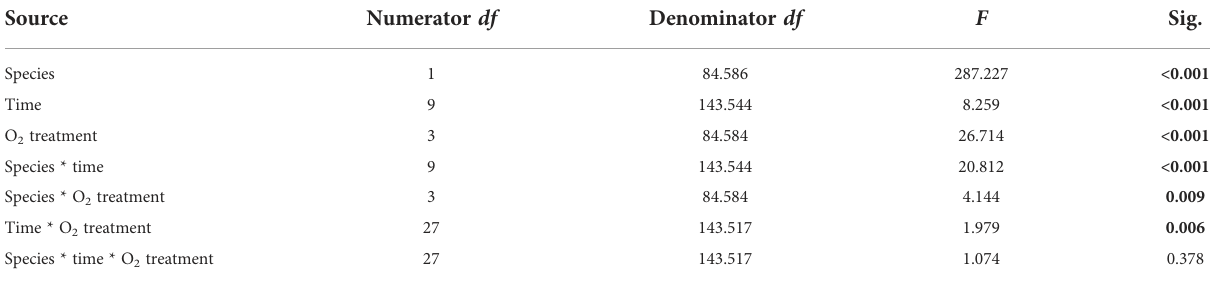
TABLE 2 Summary of results for LMMs comparing maximum F v / F m reading between treatments throughout the experiment.